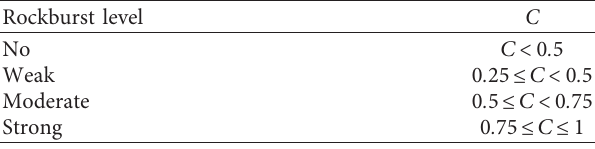
Table 1: Relationship between rockburst level and C